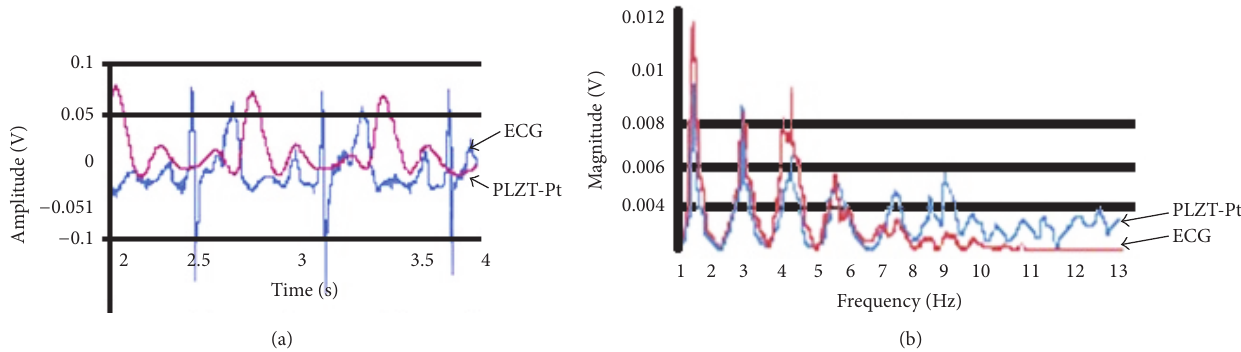
Figure 9: (a) ECG signal register and cardiac pulses monitor in effortless condition and (b) frequency spectrum recorded without effort condition.